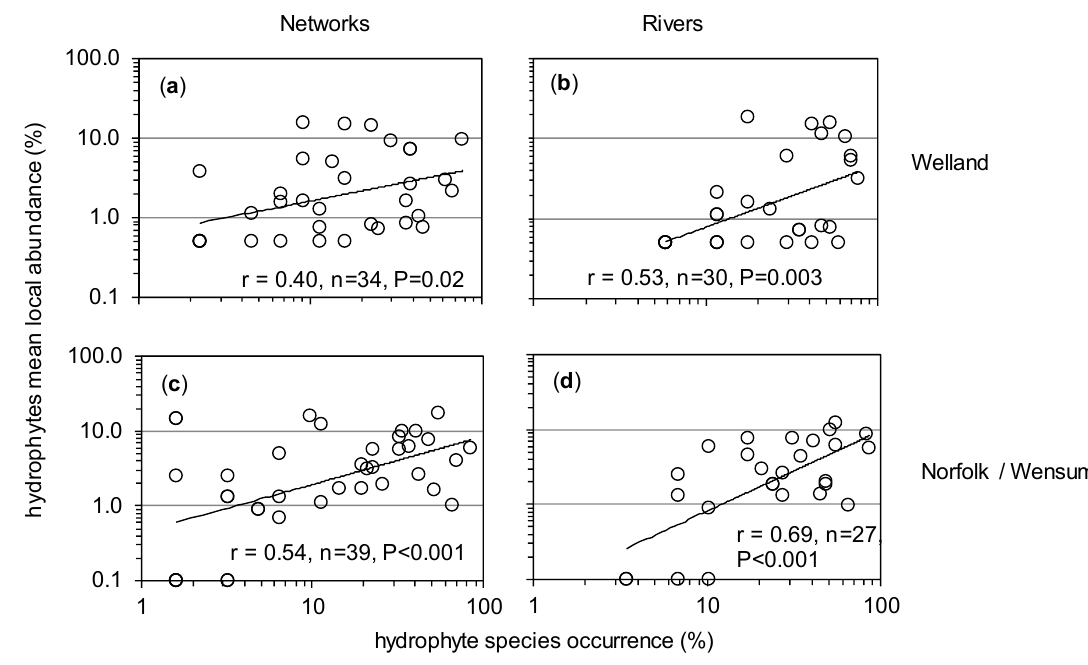
Figure 12. Abundance range size relationships across networks ( a , c ) and along rivers ( b , d ) for the Welland ( a , b ) and Norfolk/Wensum ( c , d )